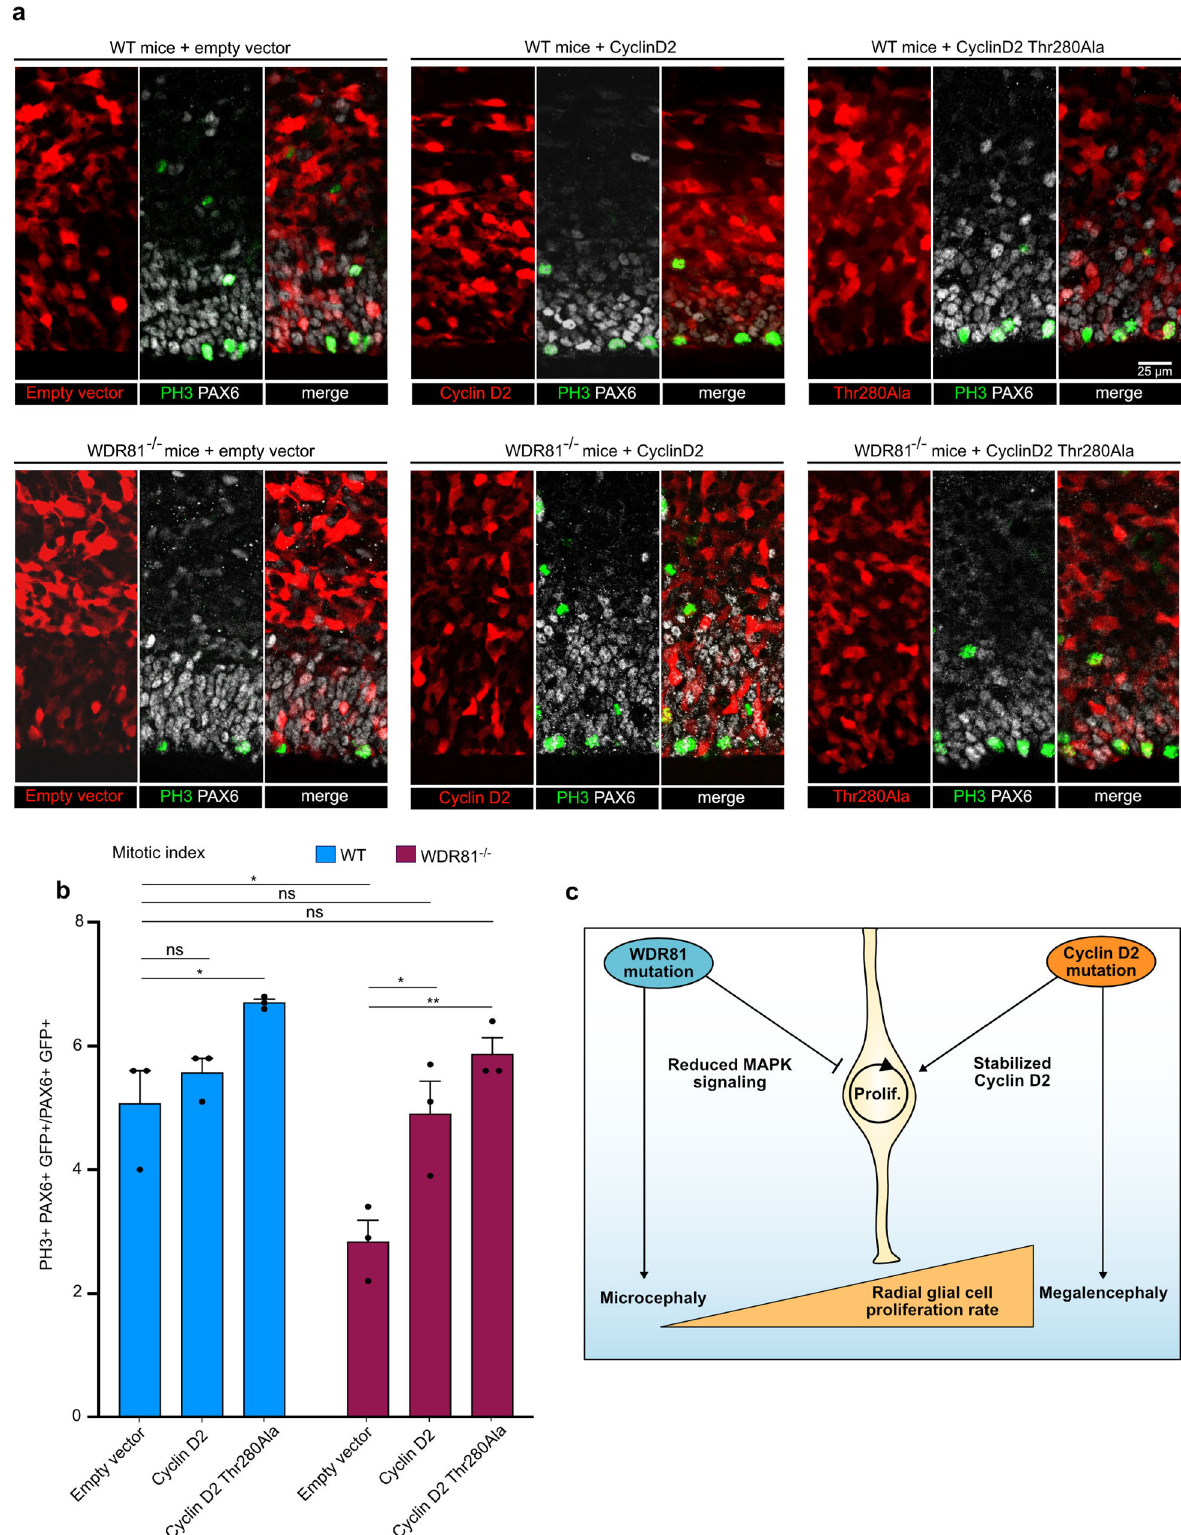
Forward: GGCGGAAAGTGGTTCTTACA, Reverse: AGCCACCTCCTGCATG AACC; for KO2 Forward: GGCTTGTAGTGGTTCTGTAC, Reverse: GATCC TTCTGCATTCCAA. For KO1 the amplicon was puri fi ed using the nucleospin puri fi cation kit (Machenery and Nagel) and then exposed to the restriction enzyme AfeI (New England Bioscience). The restriction enzyme only cuts the mutant DNA giving rise to two DNA pieces of 200 bp. For KO2, the amplicon was sanger- sequenced using the GATC-Euro fi ns